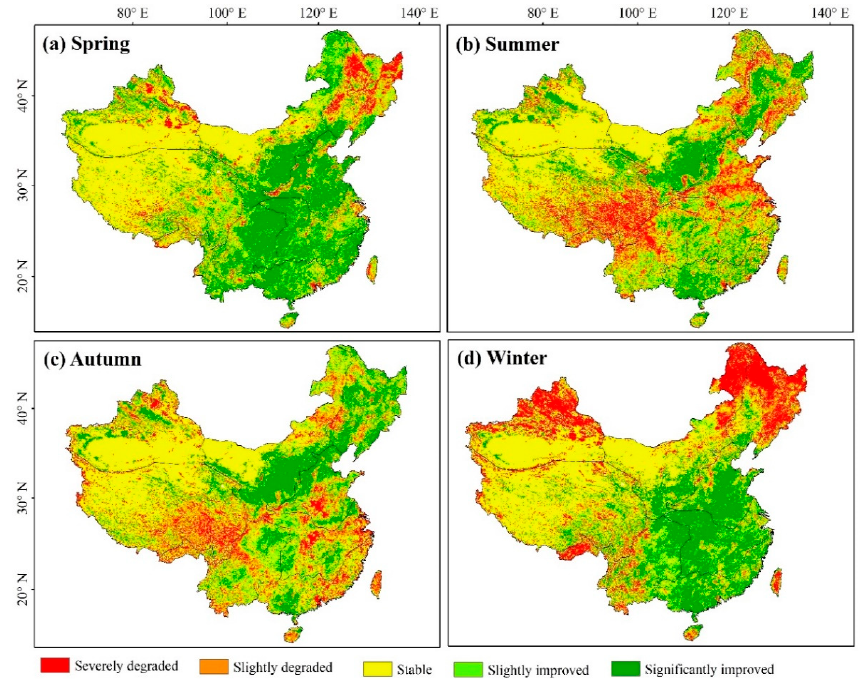
Figure 7. Seasonal variation trend in vegetation characteristics from 1982 to